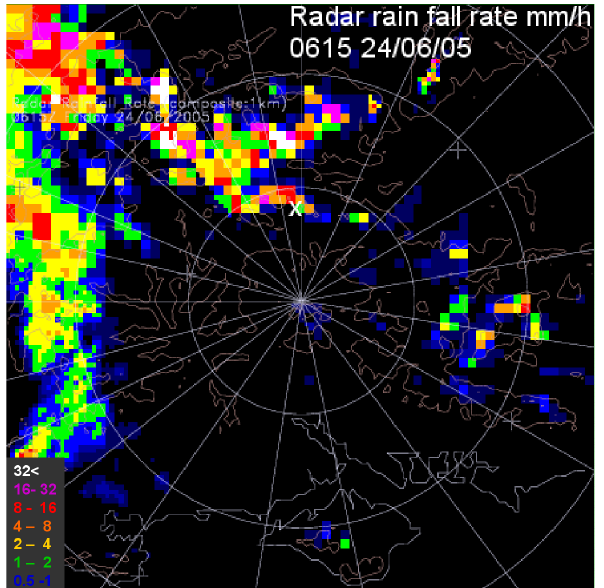
Fig. 3c. Composite weather radar rainfall for the 24 June 2005 at 06:45UTC. The white cross indicate Linkenholt site. The rain rate/h is indicated by the colour scale on the bottom left. The bulls- eye is centred at the Chilbolton radar with the first and second cir- cles of radius 25 and 50km.